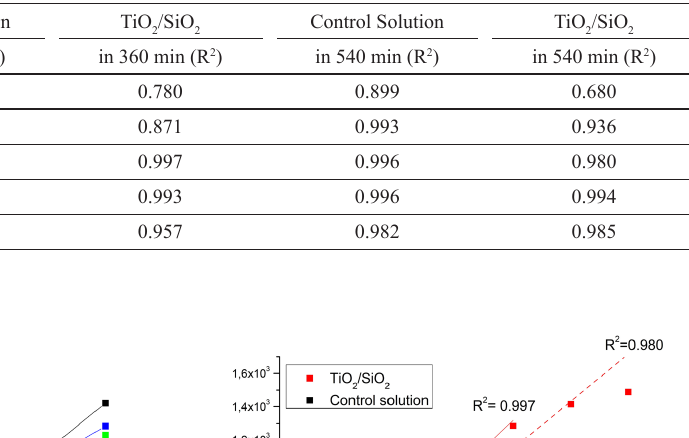
Table 3. Coefficient of determination in zero, first, second, and third-order observing the 16 th cycle of the stability test, in the control solution and the TiO /SiO reactors, for 360 and 540 minutes. 2 2